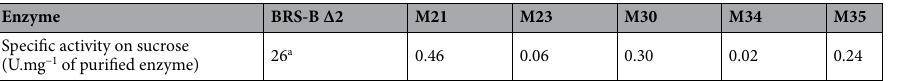
Table 1. Specific activity on sucrose (in U mg −1 of purified enzyme) was determined for mutants M21, M23,